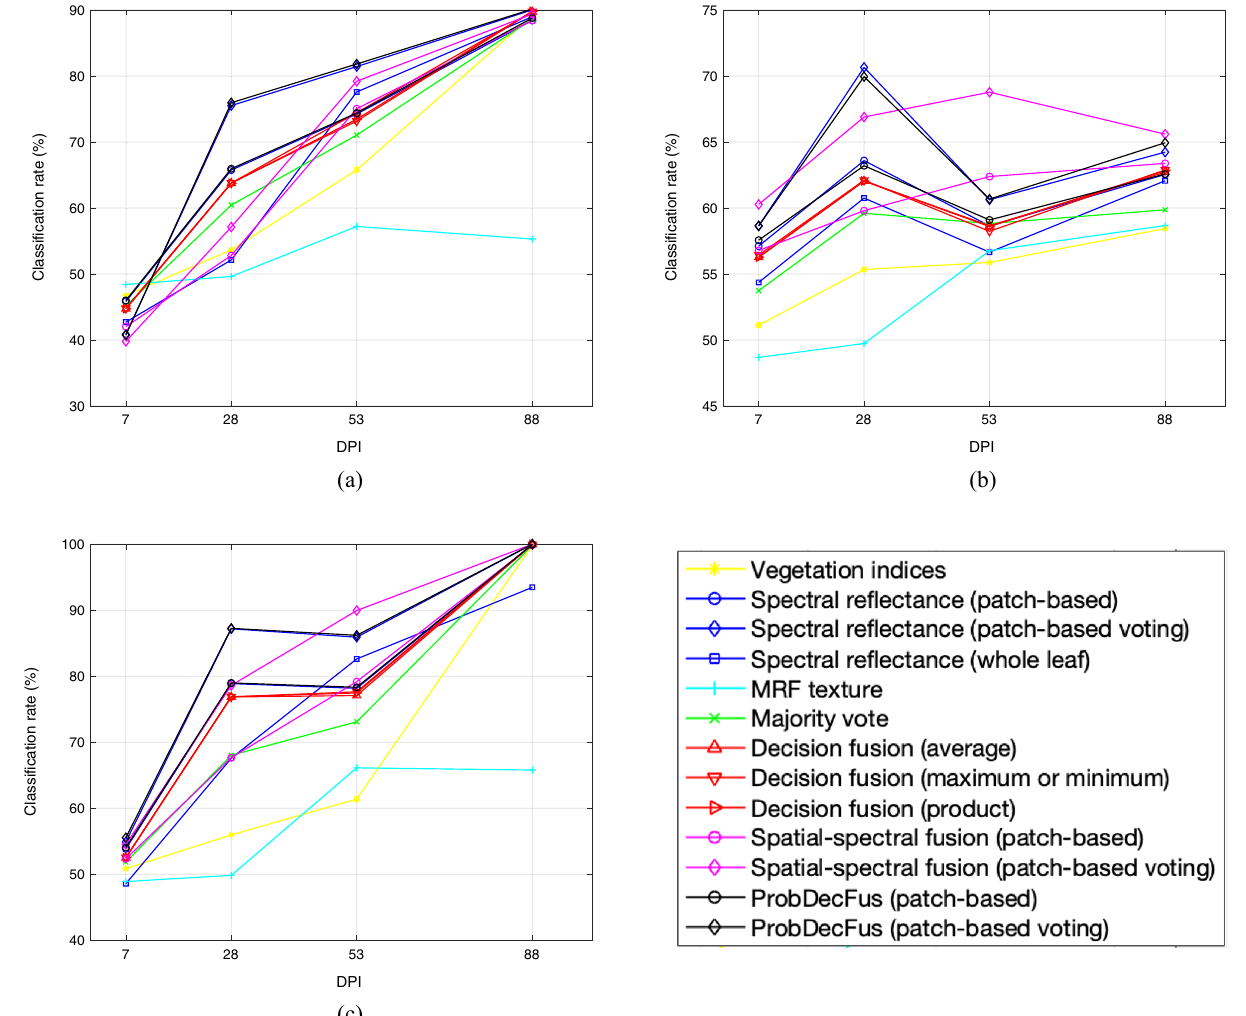
Figure 3. Classification accuracy (%) from leaf scans on Cassava-TME204-UCBSV Trial-1, at 7, 28, 53 and 88 dpi, respectively, ( a ) control versus infected, ( b ) mock versus infected, and ( c ) control versus